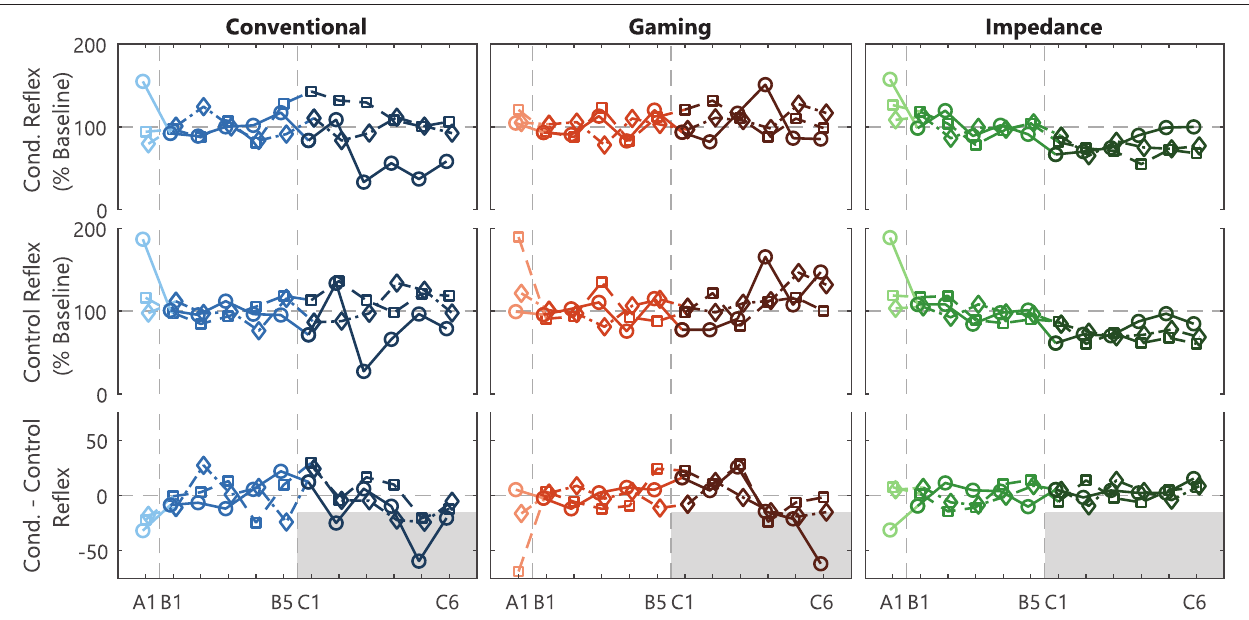
FIGURE 4 | SOL M1 reflex results and within-session effect. Individual participant traces of the average conditioned reflex (mean Blocks 1-3) and control reflex (Block 0) per session for acclimatization (A1), baseline (B1-5), and conditioning (C1-6) sessions. The within-session effect is derived from the difference between the conditioned and control reflex within a session. Conventional and Gaming groups received biofeedback on SOL M1 activity, whereas the Impedance group received biofeedback on reflexive impedance gain G . A –15% within-session effect in session C4-6 was defined as success criteria to determine feasibility of the biofeedback method for each participant, see ( gray ) shaded target area. Each icon (circle, square, and diamond) per group is linked to an individual participant and consistently used across figures.